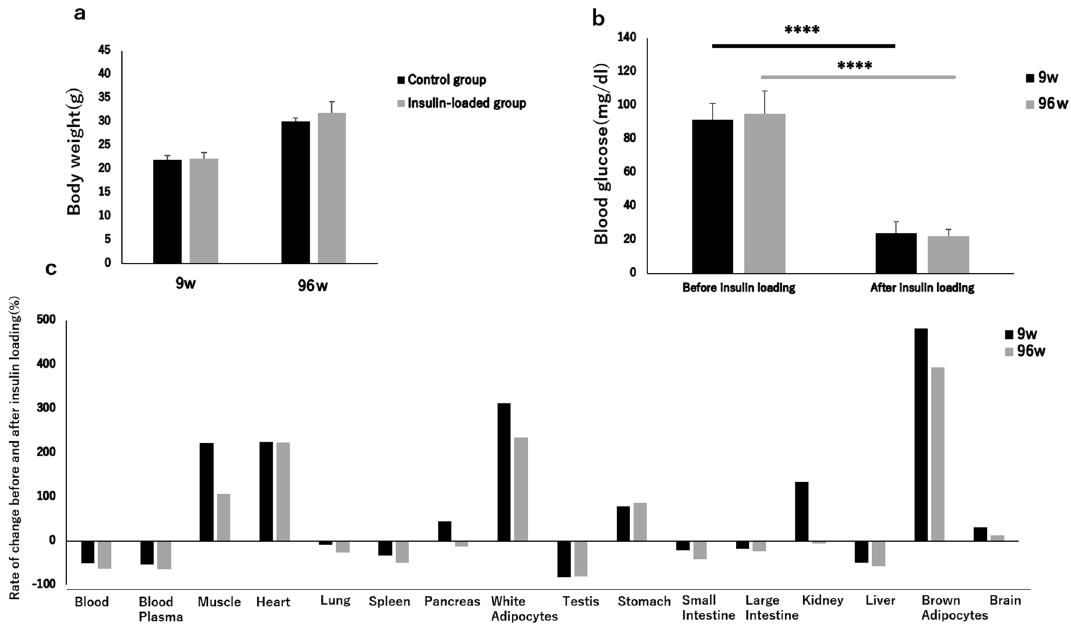
Figure 1. Body weight ( a ), blood glucose concentration ( b ), and rate of 18 F-FDG uptake changes ( c ) in organs in young and aged control and insulin-loaded groups. **** P <